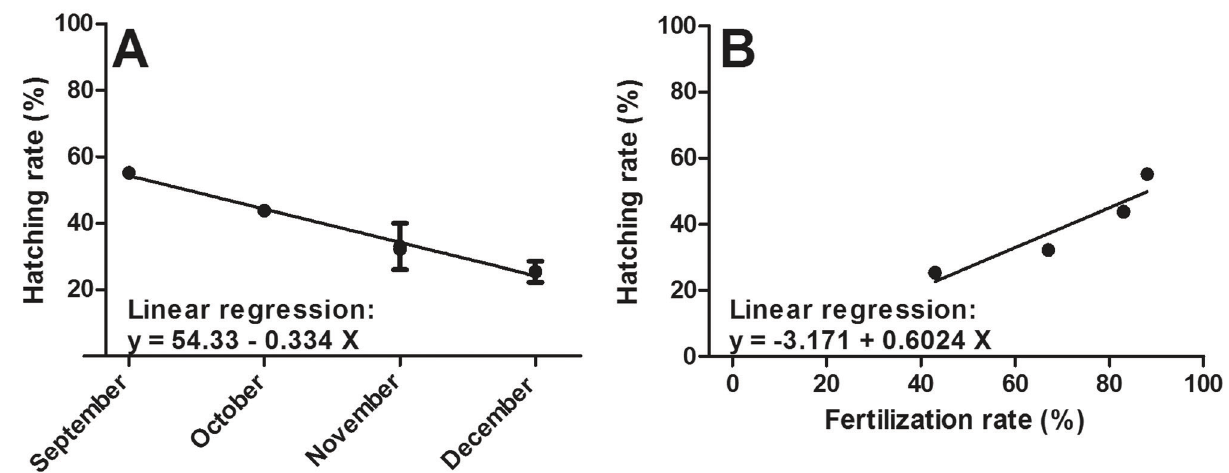
Fig. 3. ( A) Linear regression between pejerrey hatching rate and sampling dates during reproductive season; R 2 = -0.9948; P ≤ 0.05. ( B) linear regression between fertilization rate and hatching rate (square root transformed data); R 2 = 0.9478; P ≤